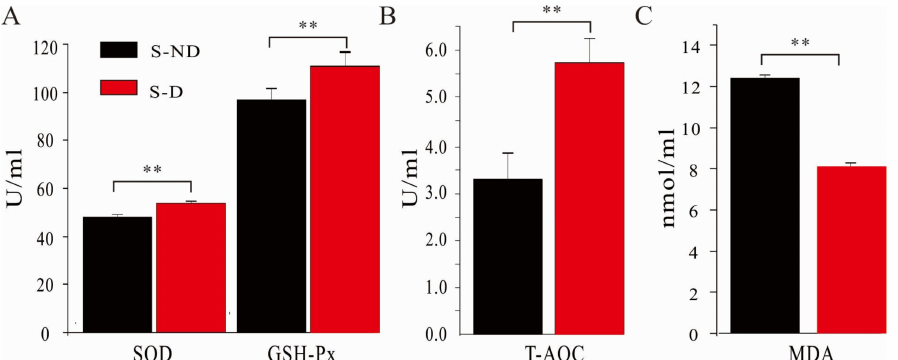
Figure 4. E ff ects of DHP on the ruminal antioxidative capacity of dairy cows under HS. Ruminal fluids were collected at 13:00 on 30 July and 07:00 and 10:00 on 31 July. ( A ) E ff ects of DHP on ruminal SOD and GSH-Px concentrations of dairy cows under HS; ( B ) e ff ects of DHP on ruminal T-AOC level of dairy cows under HS; ( C ) e ff ects of DHP on ruminal MDA concentration of dairy cows under HS. **: p <